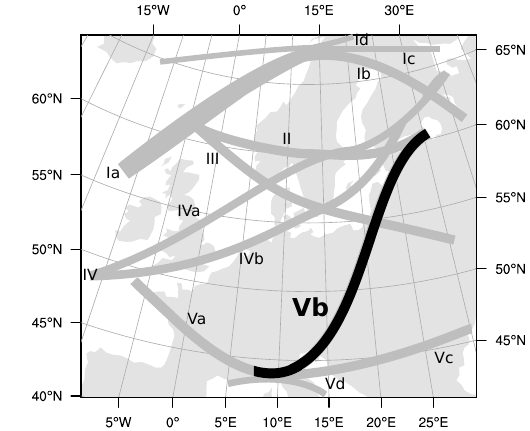
Figure 1. Trajectories of the barometric minima between 1876– 1880, as defined by W. J. van Bebber in 1981. The trajectory that defines Vb cyclones is highlighted in